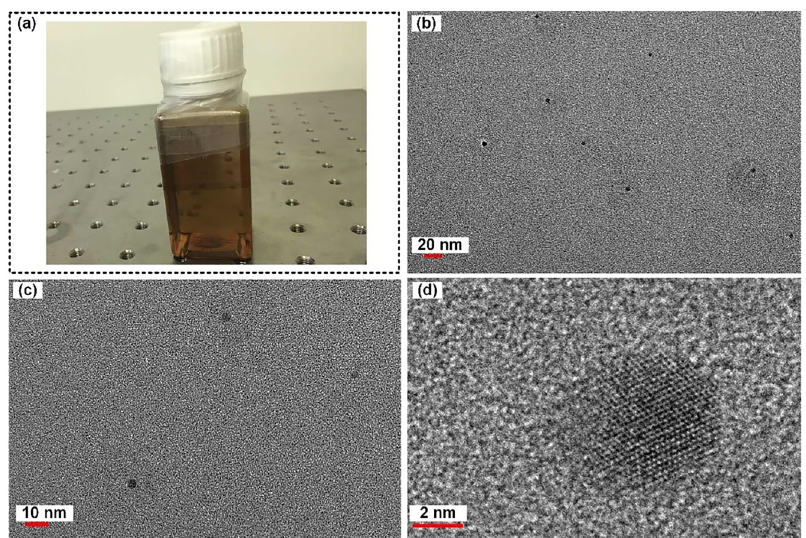
Figure 2: (a) BPQDS/H 2 O solution; (b) and (c) different scales of TEM; (d) HRTEM. are ∼ 30, ∼ 18.5, and ∼ 15 μ m, corresponding to taper lengths of ∼ 20, ∼ 25, and ∼ 30 mm, respectively. itedonto these TF and DF devices to enable evanescent-field